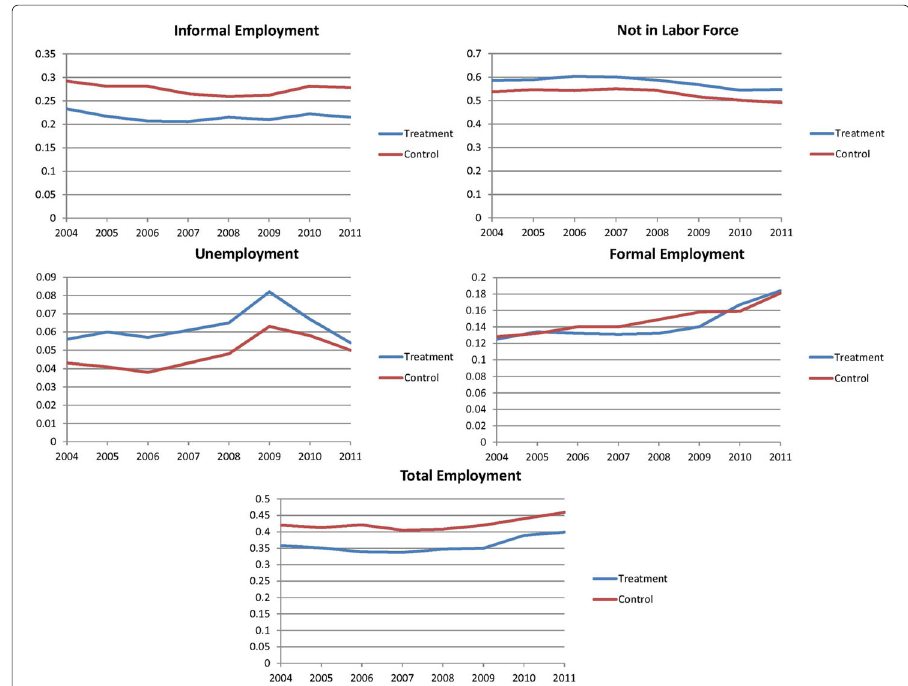
Fig. 3 Prior trends in treatment versus control areas. The figures above compare the trends in the labor market outcomes in treatment versus control areas prior to immigration (i.e., between 2004 and 2011). Note that all variables are characterized in terms of their ratios to the population of native individuals of age 15–64. For example, the unemployment rate should be read as the ratio of unemployed individuals to the population of individuals aged 15–64. The figures suggest that the prior trends are quite similar across treatment and control